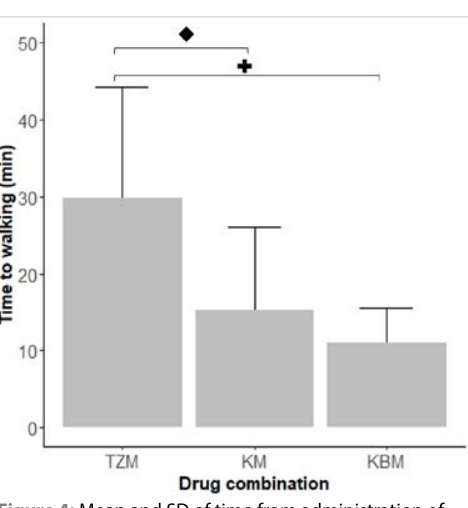
Figure 4: Mean and SD of time from administration of antagonist in free-ranging African lions ( Panthera leo ) immobilised with tiletamine-zolazepam-medetomidine Figure 3: Mean and SD of systolic arterial pressure in free-ranging African lions (TZM), ketamine-medetomidine (KM) or ketamine- ( Panthera leo ) immobilised with tiletamine-zolazepam-medetomidine (TZM), butorphanol-medetomidine (KBM). Note:  denotes a ketamine-medetomidine (KM) or ketamine-butorphanol-medetomidine (KBM). difference between TZM and KM;  denotes a difference Note: Shaded area represents: Normal systolic arterial pressure (White & Seymour between TZM and 2014)); * denotes a difference between T and T in the TZM group; † denotes a 30 0 difference betweenT and T in the KM group; # denotes a difference betweenT 30 0 30 and T in the KBM group;  denotes a difference between TZM and KM;  denotes 0 a difference between KM and KBM.